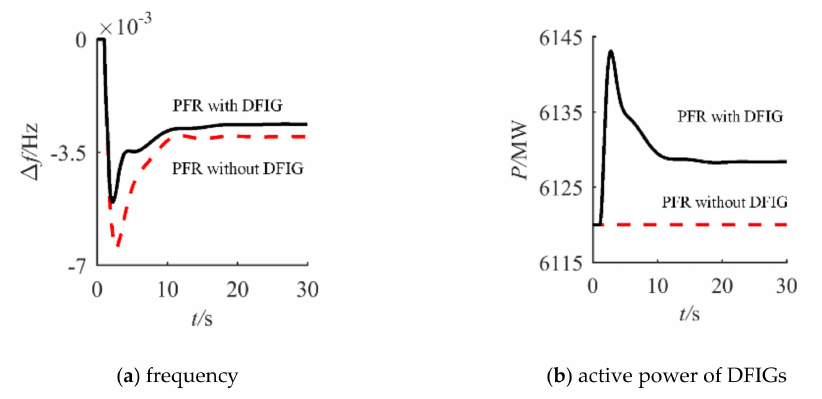
Figure 11. Simulation results with a loss of 66 MW generation, ( a ) for the system frequency, ( b ) for the active power of the DFIGs.